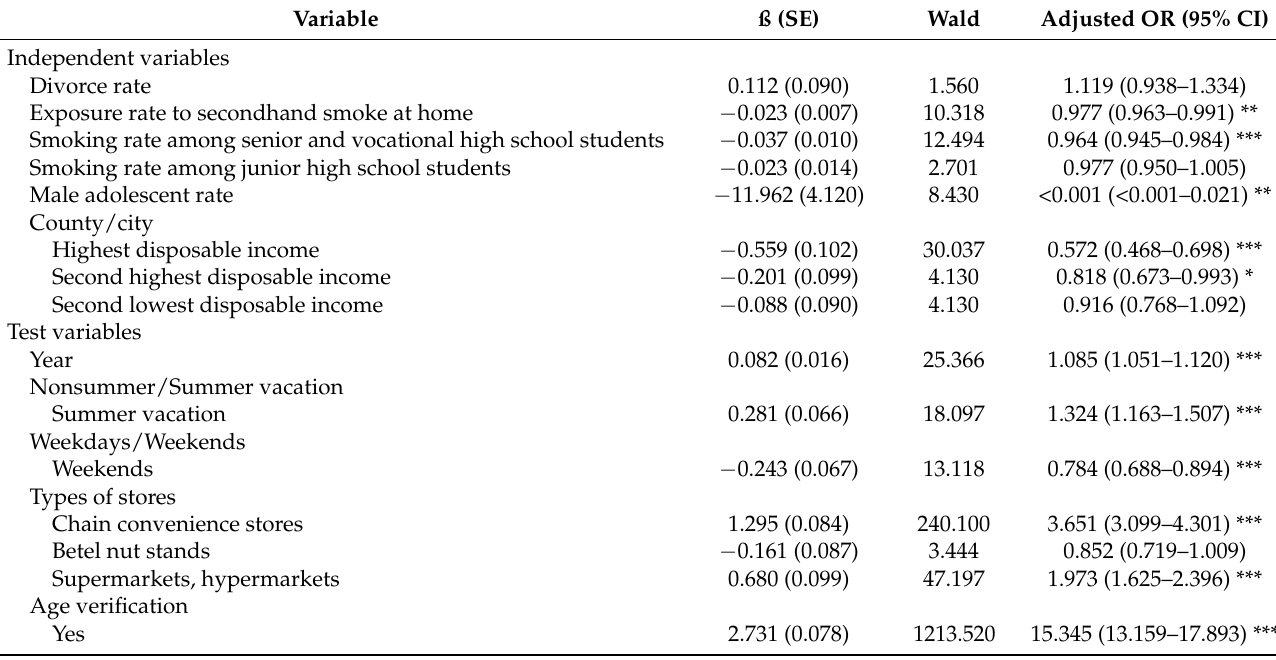
Table 2. Influencing factors of test results (compliance vs.